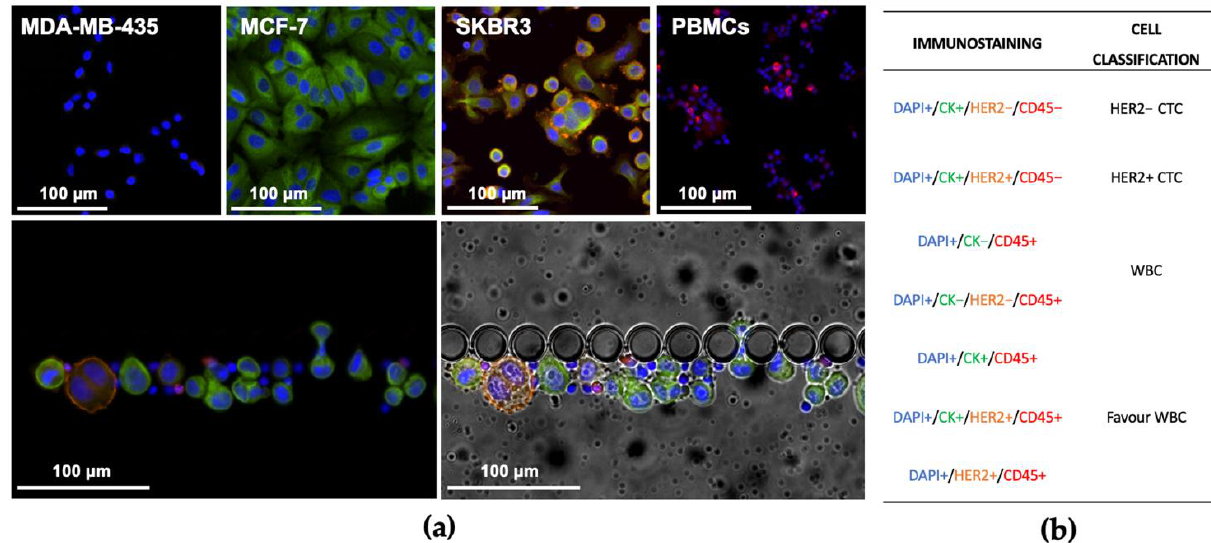
Figure 3. ( a ) Images obtained from the immunocytochemistry experiments in cultured adhered cells (top images) and in cells released into solution inside the device (bottom images). ICC experiments were performed using MCF-7, MDA-MB-435, SKBR3 and PBMCs. Each cell line was tested individually in glass slides (top); additionally, a cell mixture of the different cell lines was spiked in healthy whole blood samples and processed in the device (bottom). MCF-7 cells stained strongly for CK, with cytoplasm localization; SKBR3 cell membrane stained positively for HER2; most PBMCs stained for CD45. ( b ) For further image analysis, CTC classification was established according to the combination of the presence and absence of the selected biomarkers, and CD45 is used as CTC exclusion criteria.